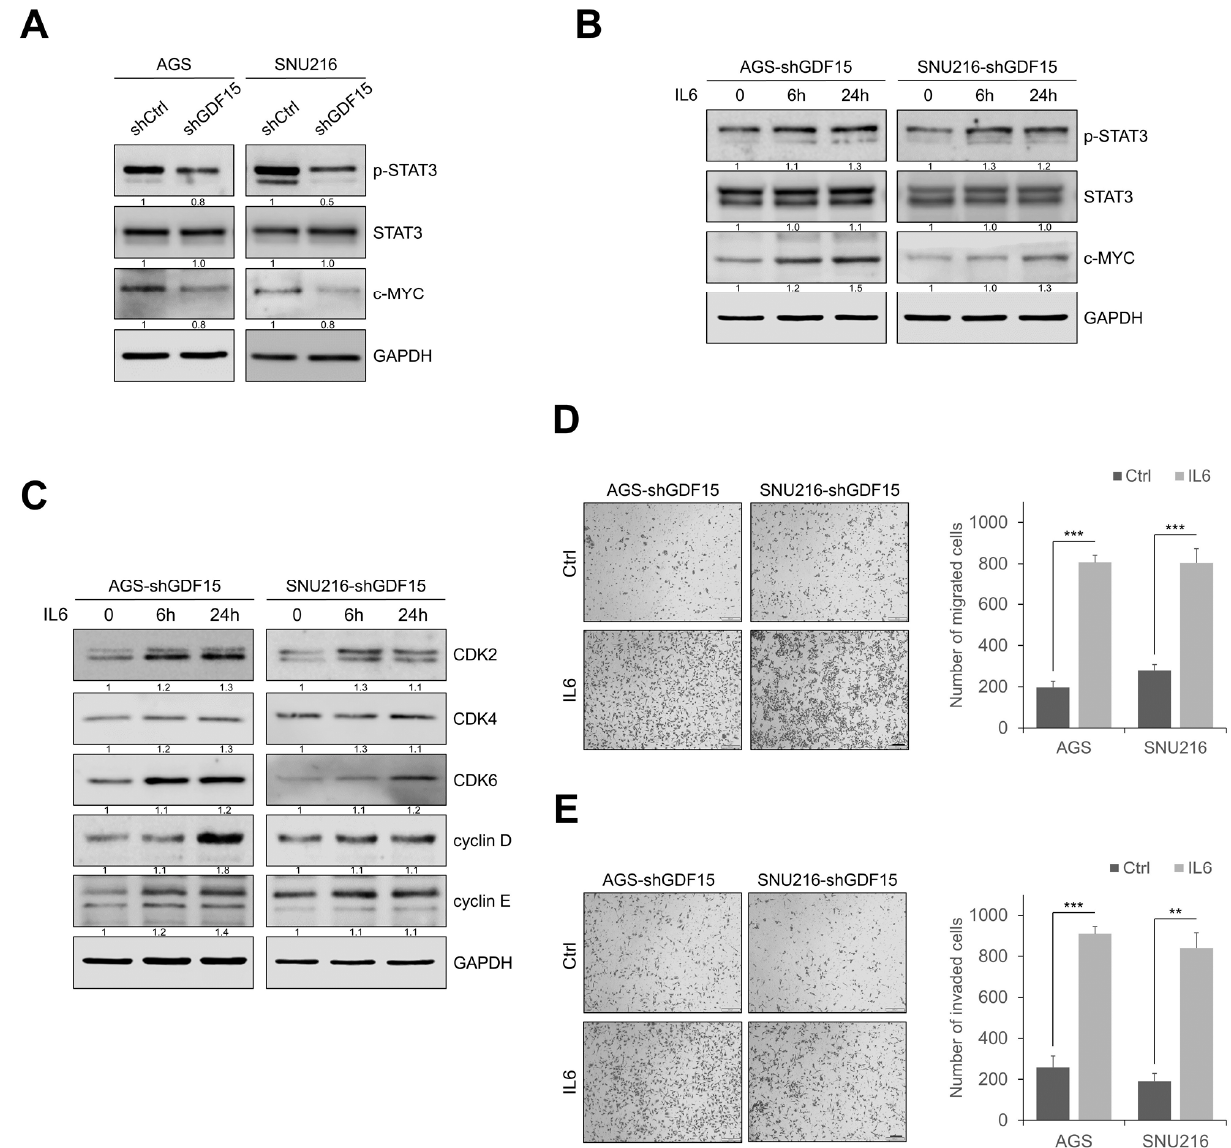
Figure 4. GDF15 knockdown suppresses STAT3 activation. ( A ) Western blotting analysis showing decreased expression of phosphorylated STAT3 and c-MYC in GDF15-knockdown cells compared with shCtrl cells. ( B ) GDF15-knockdown cells were treated with 200 ng/mL of IL-6 for 24 h. Western blotting analysis showed that IL-6 significantly increased the expression of phosphorylated STAT3 and c-MYC. ( C ) Western blot showing the expression of cell-cycle-related proteins in GDF15-knockdown cells treated with IL-6. ( D , E ) In transwell assays, migration and invasion were increased in GDF15 knockdown cells treated with IL-6. Cells were counted in five randomly selected fields. Data are presented as the means ± SD and were evaluated using Student’s t -test ( n = 3). Scale bars, 100 µ m. ** p < 0.01, and *** p < 0.001.